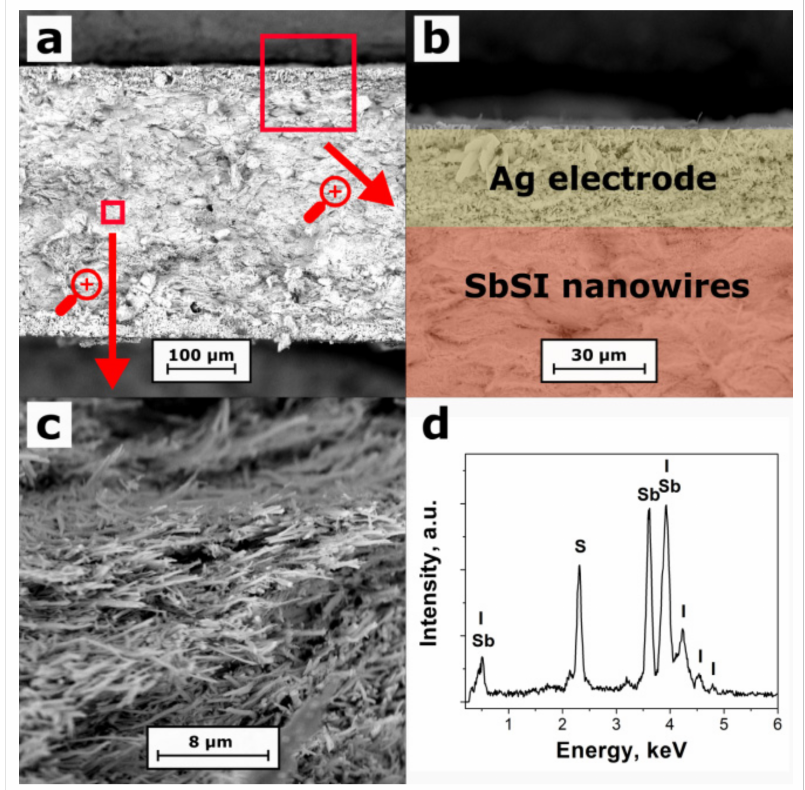
Figure 3. SEM images of the cross-section ( a ), edge ( b ) and interior ( c ) of the compressed SbSI nanowire sample, as well as its EDS spectrum ( d